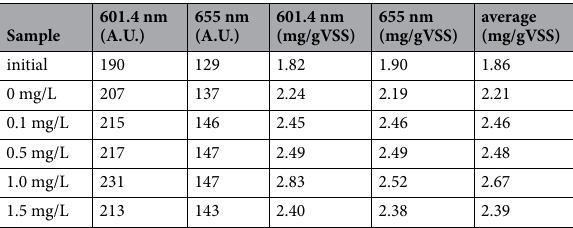
Table 3. Fluorescence intensity and concentration of heme.